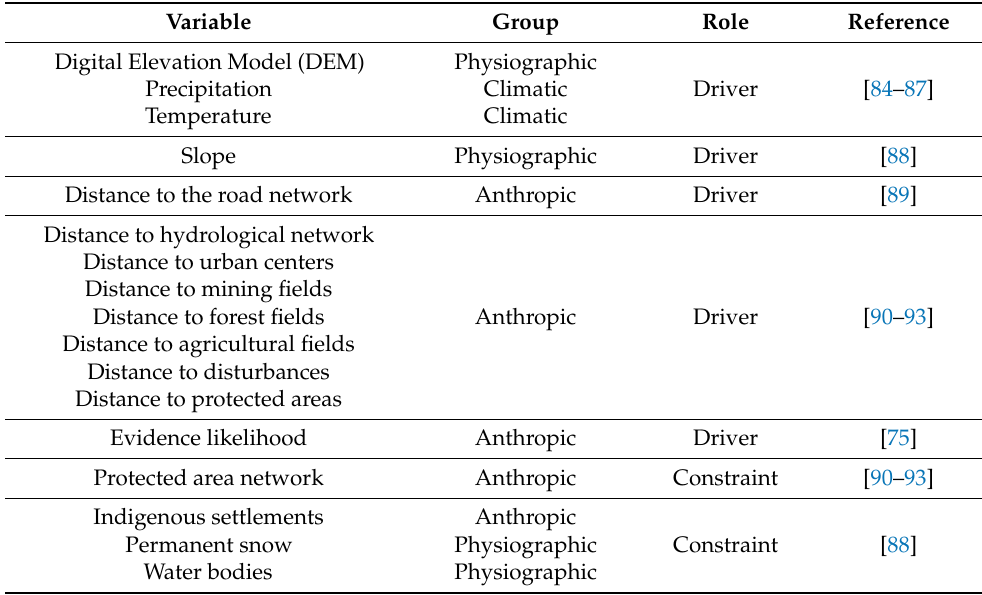
Table 1. Drivers and constraints used for the calibration